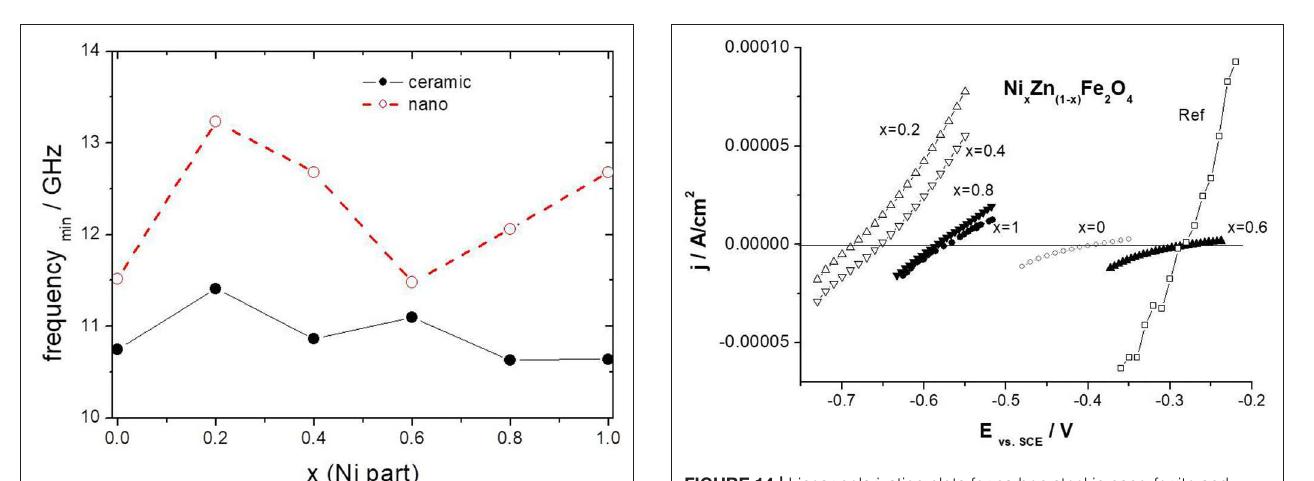
Figure 13 shows the polarization curves for the carbon